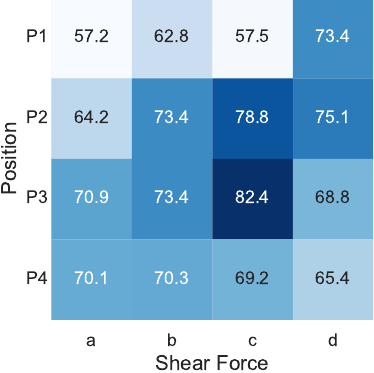
Figure 11. F1 score of shear force at each position